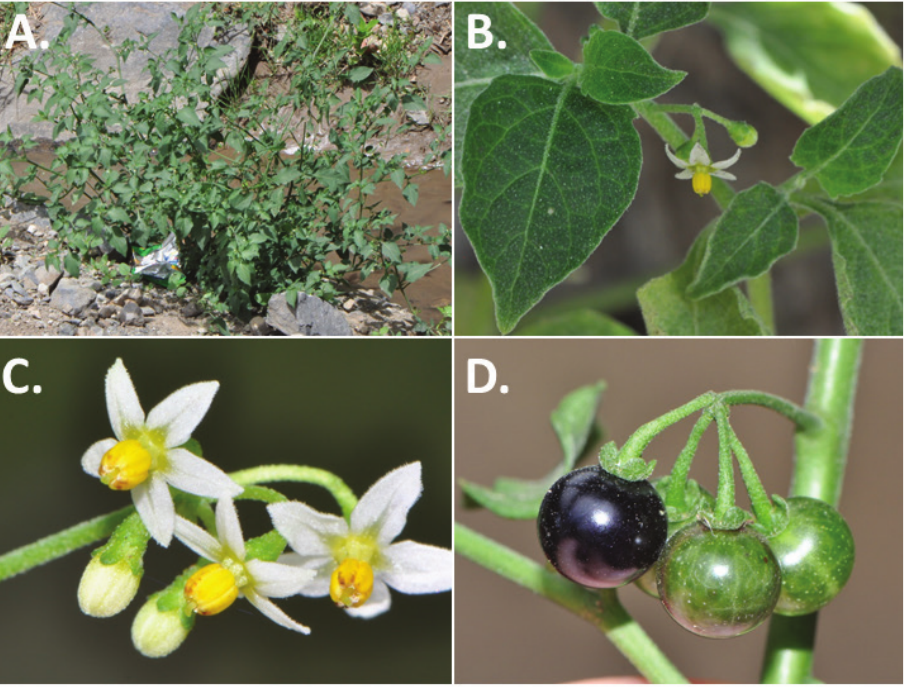
Figure 4. Solanum americanum Mill. A Habit B leaves and young inflorescence C buds and flowers D mature, shiny black fruits with reflexed calyx lobes ( A, D Knapp et al. 10210 ; B Knapp et al. 10205 C Knapp et al. 10360 ). Photos by S.